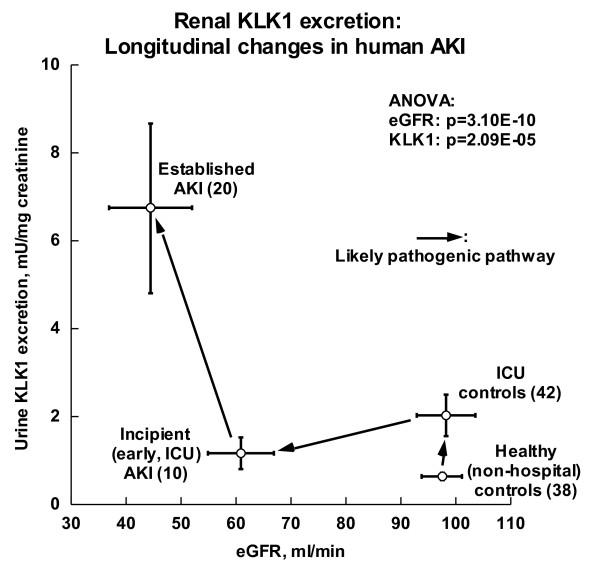
Urinary kallikrein activity in AKI: Cases versus controls. Results are shown for both KLK1 excretion and eGFR in 4 groups: established AKI, incipient (early, ICU) AKI, ICU controls, and healthy (non-hospital) controls. Results (shown as mean ± 1 SEM) were analyzed by ANOVA, factoring for age, sex and race.